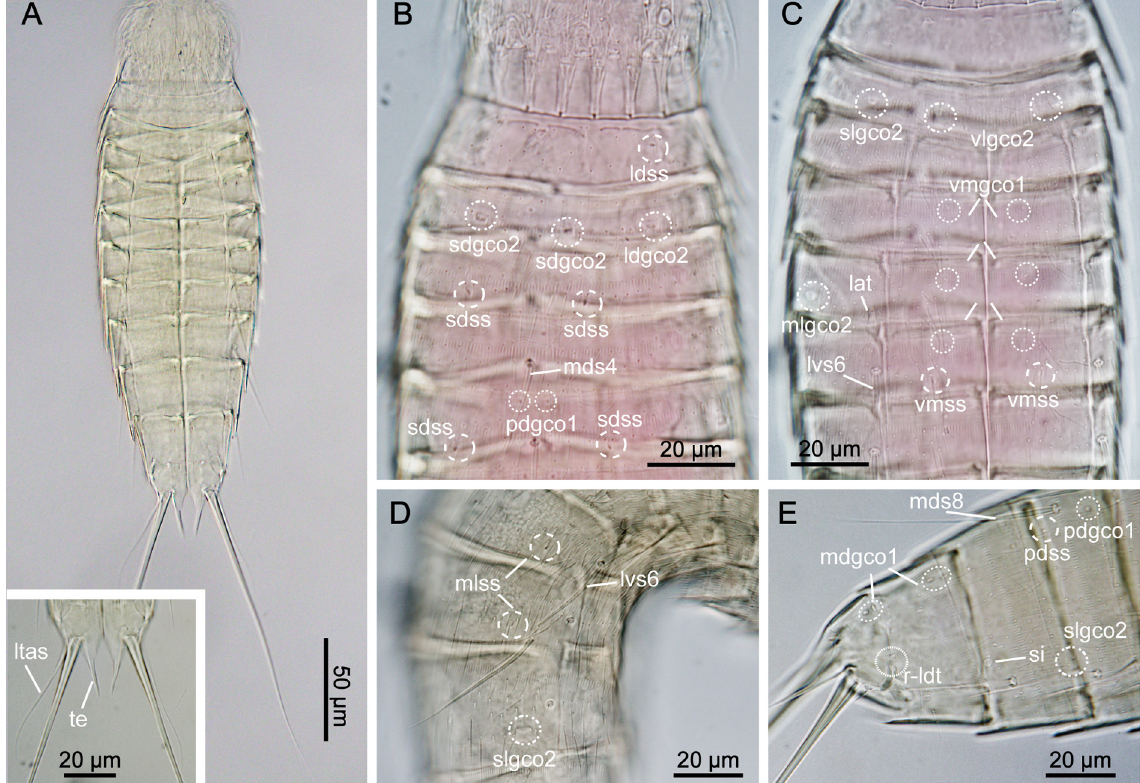
Fig. 30. Light micrographs showing overview and details of Echinoderes galadrielae sp. nov. A . ♀, paratype (NHMD-921497). B–C . ♀, holotype (NIWA-159425). D . ♀, paratype (NHMD-921496). E . ♀, paratype (NIWA-159426). A . Ventral overview, with inset showing close-up of segment 11. B . Segments 1 to 5, dorsal view. C . Segments 1 to 7, ventral view. D . Segments 6 to 8, lateral view. E . Segments 8 to 11, lateral view. Abbreviations: see Material and